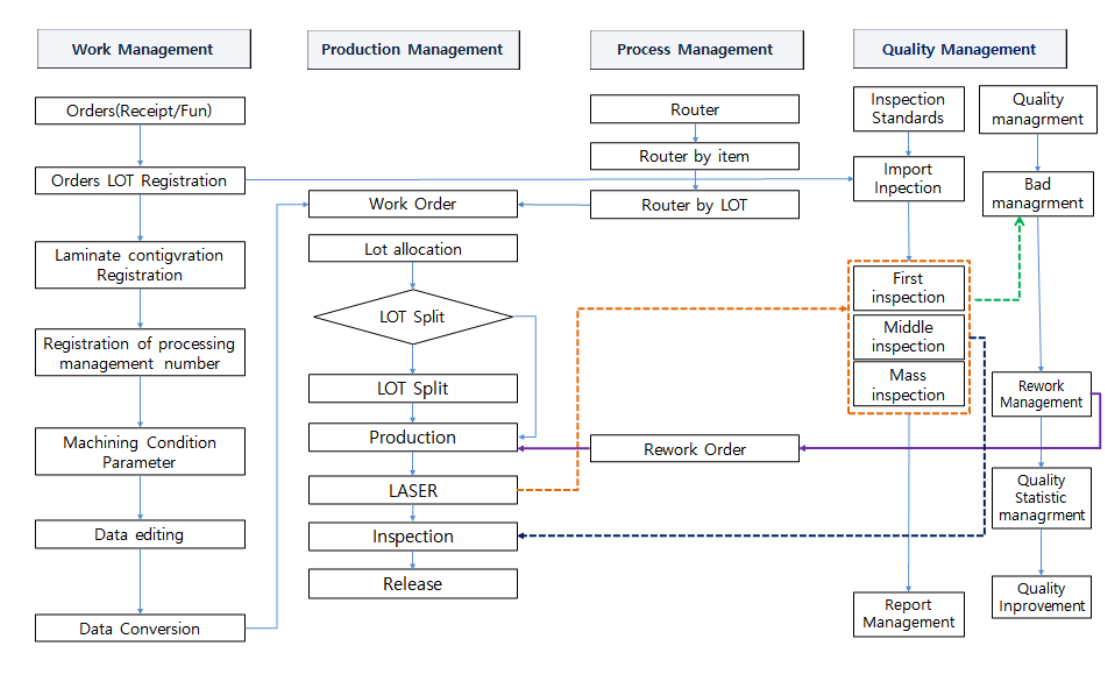
Figure 7. A flow diagram of an overall business